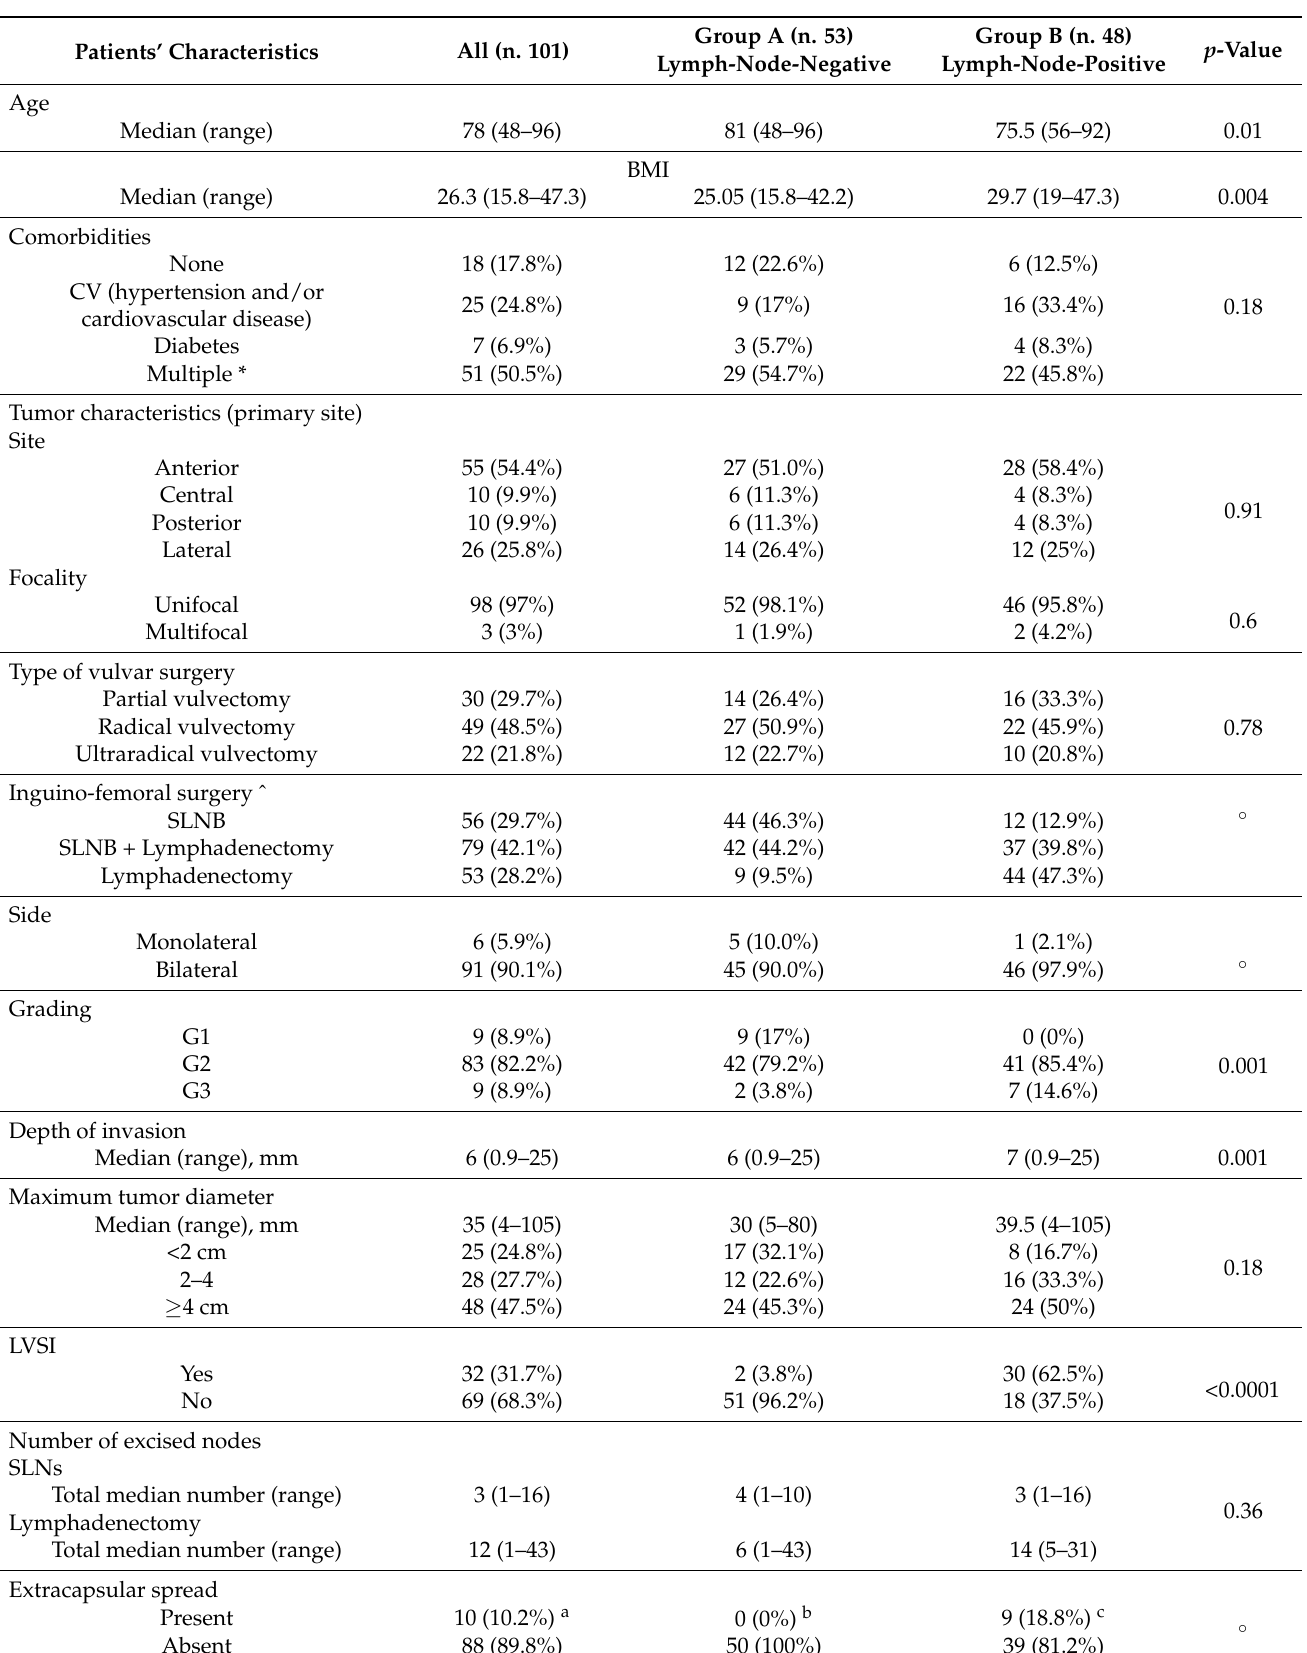
Table 1. Patients’